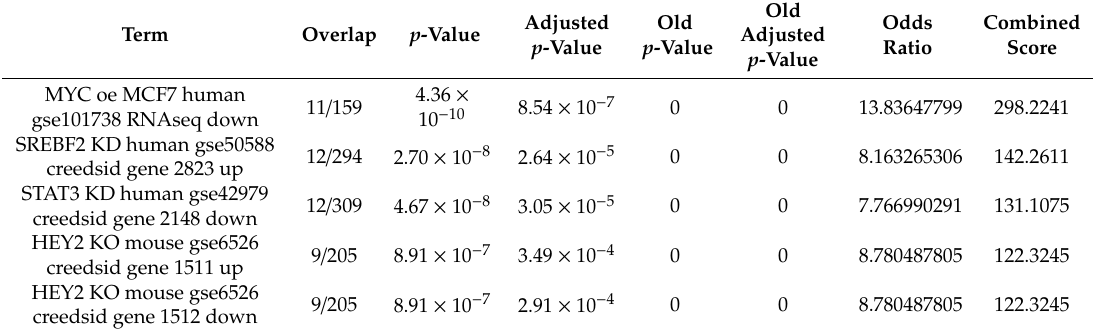
Table 1. Digoxin gene set enrichment analysis.